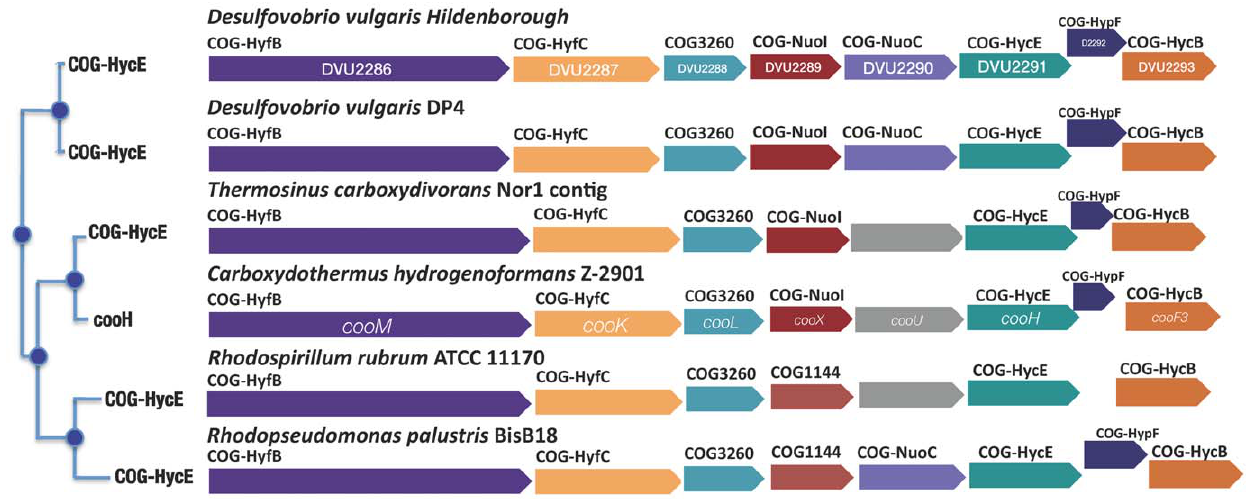
Figure 4. Conservation of the operon encoding DVU2291 between the d -proteobacteria, the a -proteobacteria and the Clostridia.